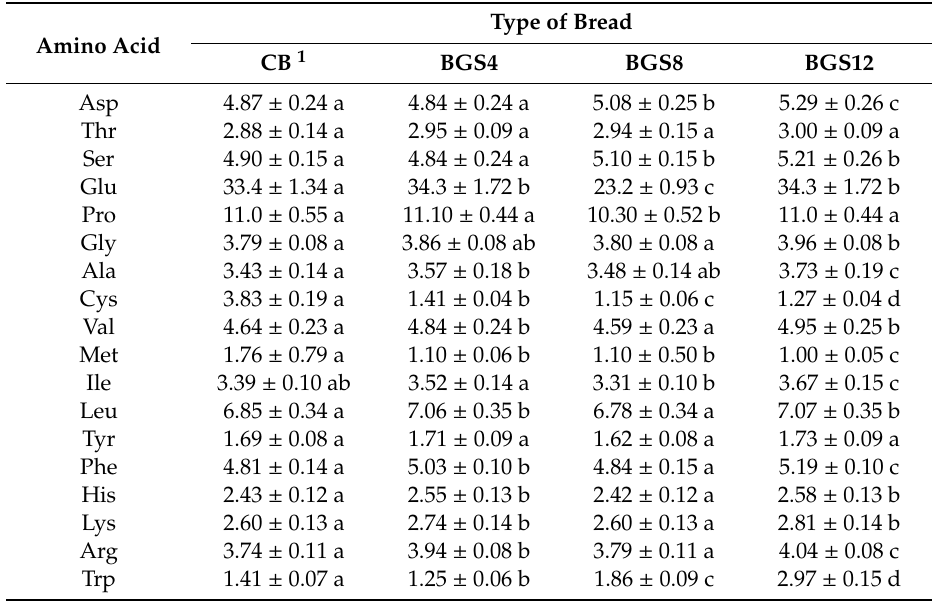
Table 6. The content of amino acids in control bread and breads enriched with green spelt grain, oat grain and sprouted lentil seeds [mg g − 1